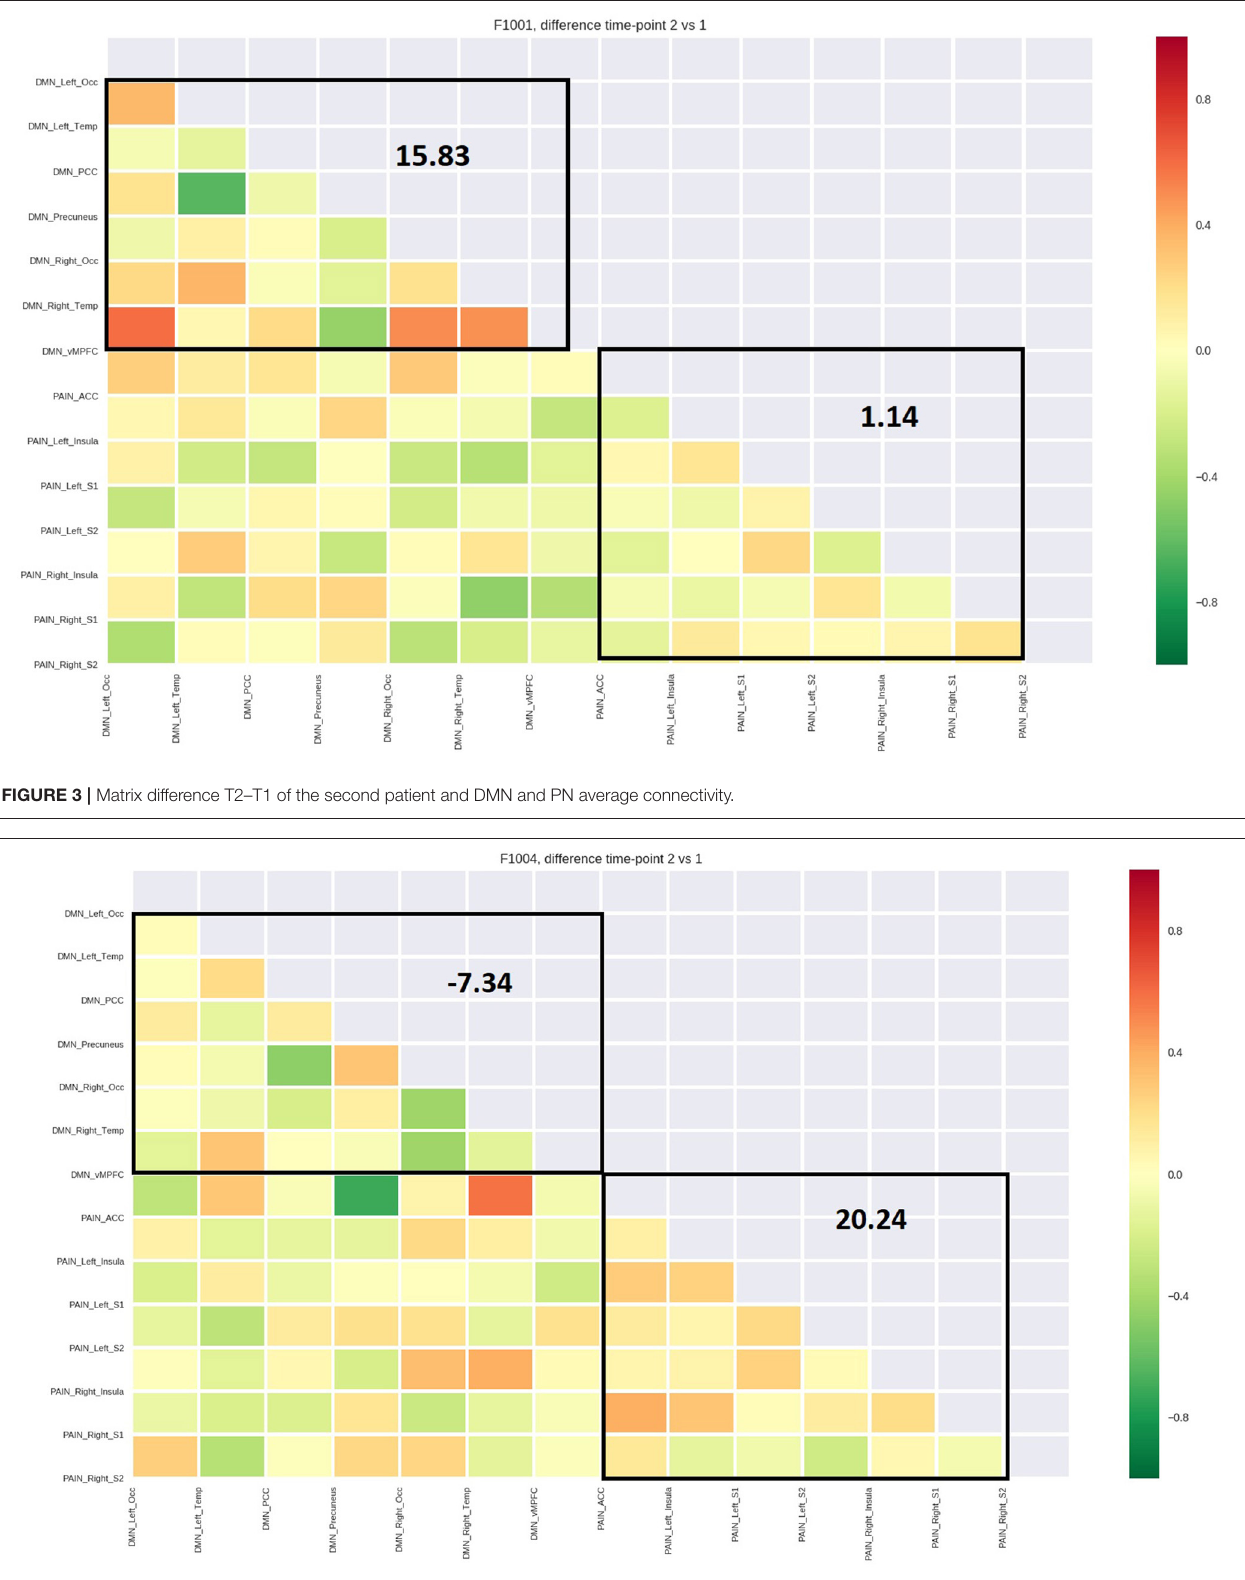
FIGURE 4 | Matrix difference T2–T1 of the third patient and DMN and PN average connectivity.